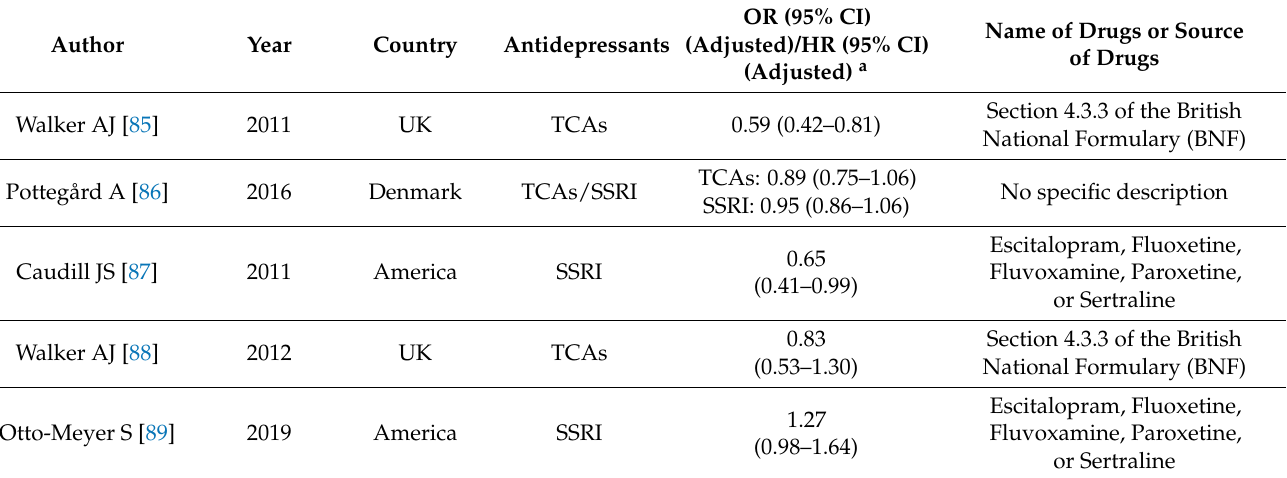
Table 2. Characteristics of articles on the relationship between antidepressants and